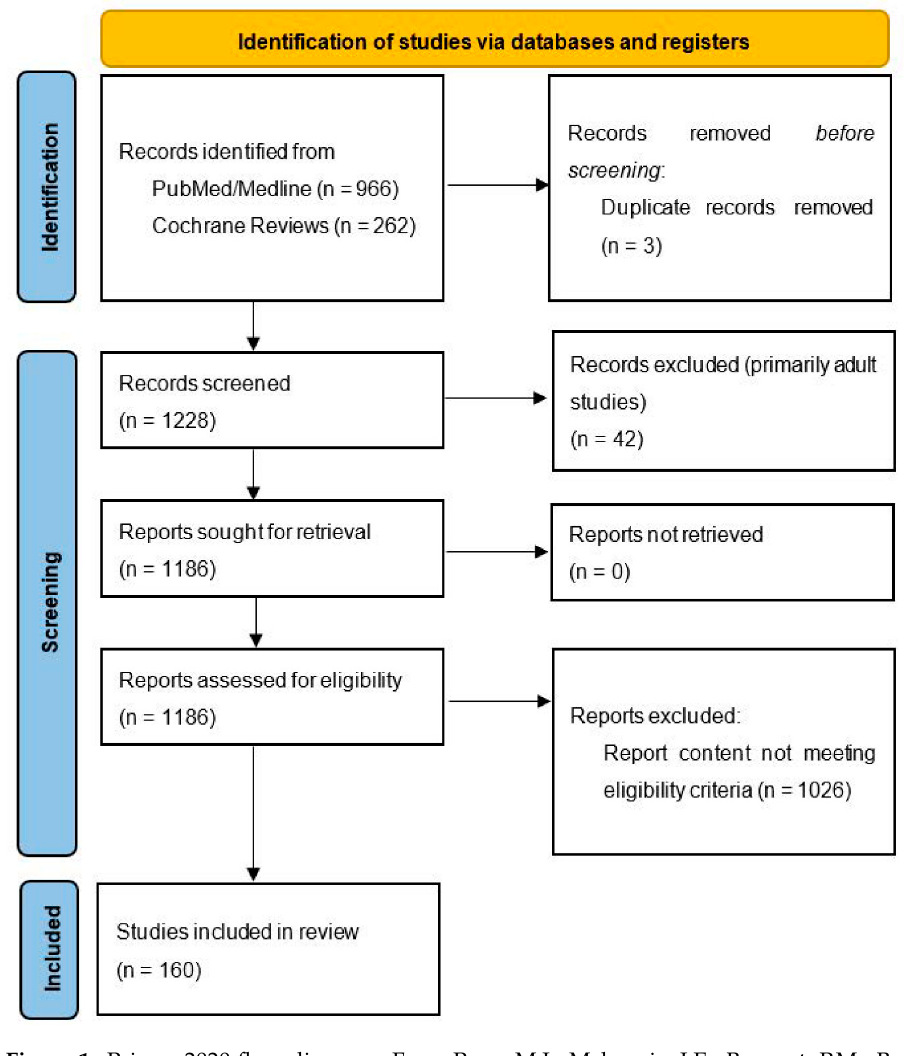
Figure 1. Prisma 2020 flow diagram. From Page, M.J.; Mckenzie, J.E.; Bossuyt, P.M.; Boutron, I.; Hoffmann, T.C.; Mulrow et al. The PRISMA 2020 statement: an updated guideline for reporting